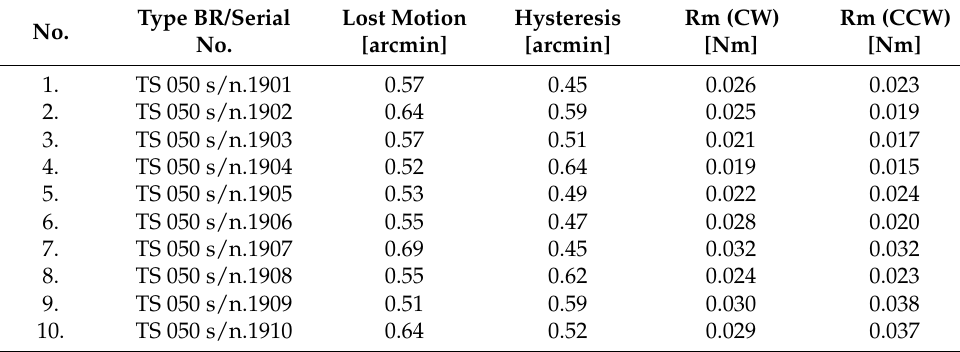
Figure 12. Starting torque BS TS 050-63, s/n.1901—CCW direction (after the trial run).